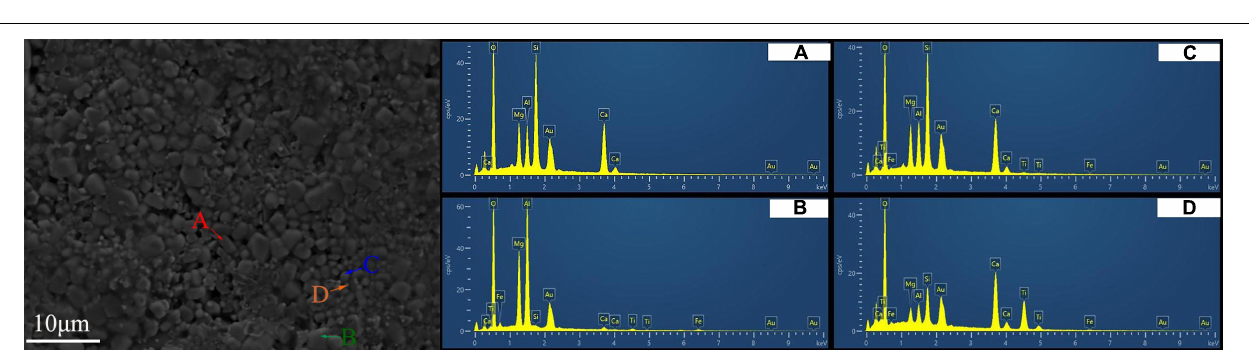
FIGURE 3 | Scanning electron microscope images of EBFS ceramics: (A) EBFS-1000, (B) EBFS-1100, (C) EBFS-1150, (D) EBFS-1180, (E) EBFS-1200a, and (F) EBFS-1200b.